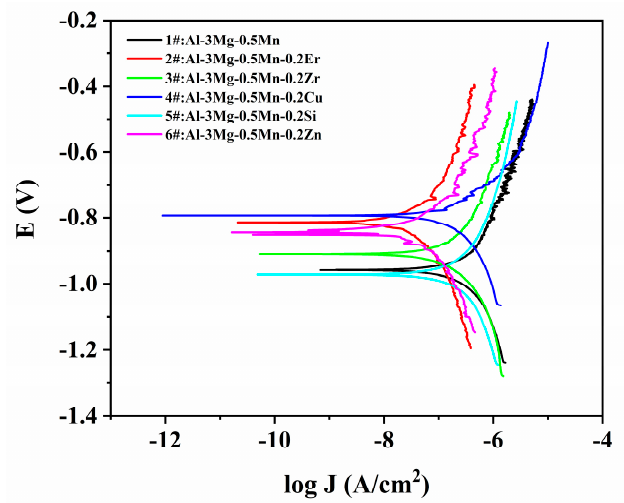
Figure 11. Polarization curve of cold rolled alloys in 3.5wt.% NaCl